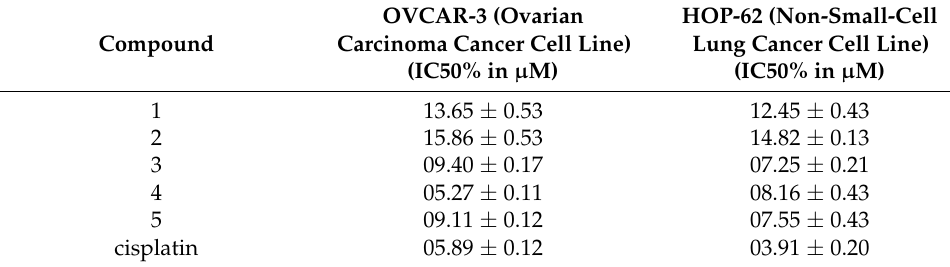
Table 3. Anticancer activities of the gold compounds and cisplatin in DMSO solutions.